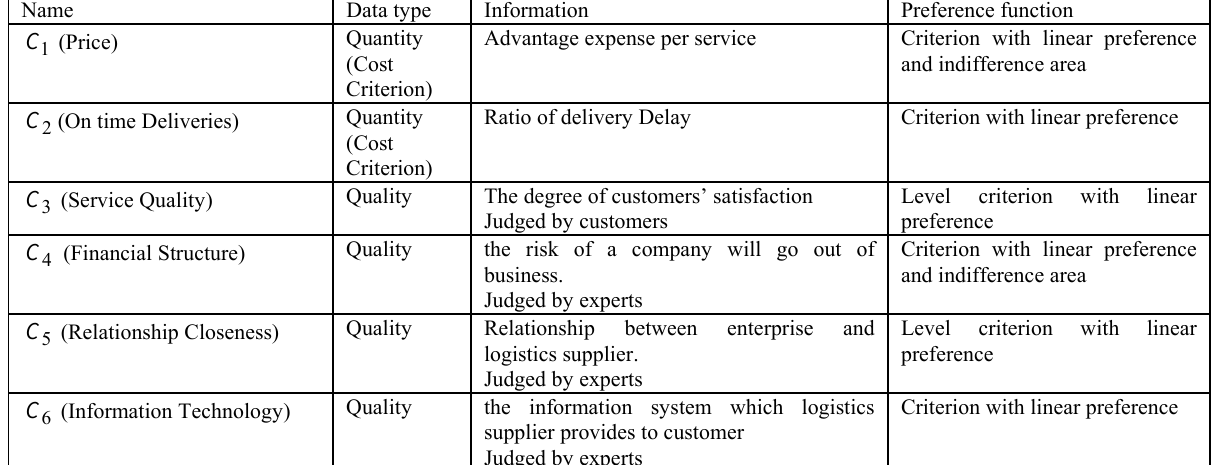
Table 3. The Description of the criteria